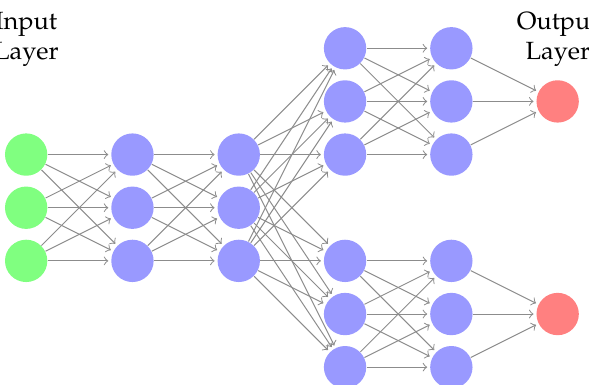
Figure 4. Example of a multi-task architecture A α with n = 3, m = 2, and α = 2. For simplicity, bias units are not